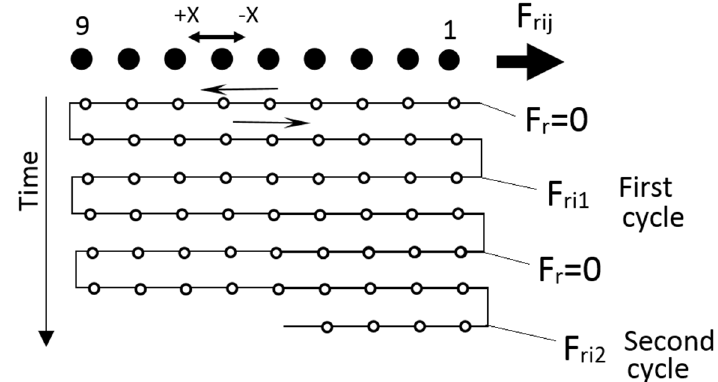
Figure 5. Second measurement scenario scheme. F rij —Force in the “r” direction, in the “i” position, with the load “j”. F ri1 —Load value as a force applied in the first cycle.